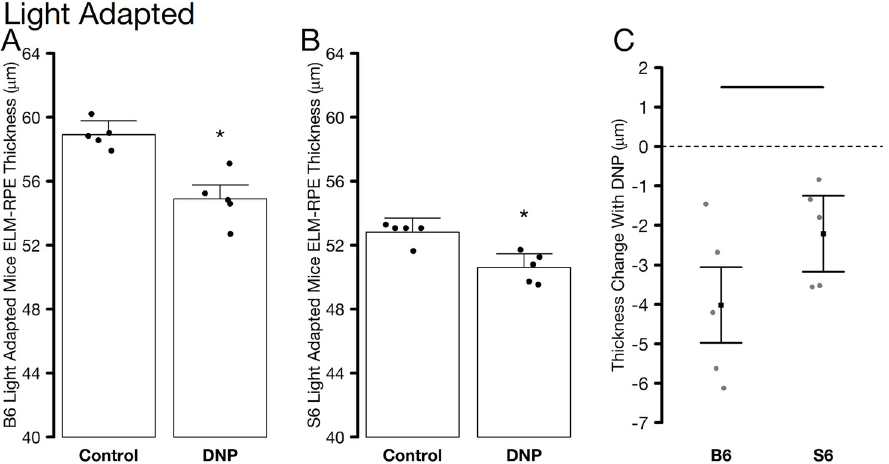
Fig 6. Summary of average ELM-RPE thickness measured from OCT images of light-adapted control and DNP treated A) B6 and B) S6 mice. C) Paired differences to account for changes within mice. All graphing conventions are as in Fig